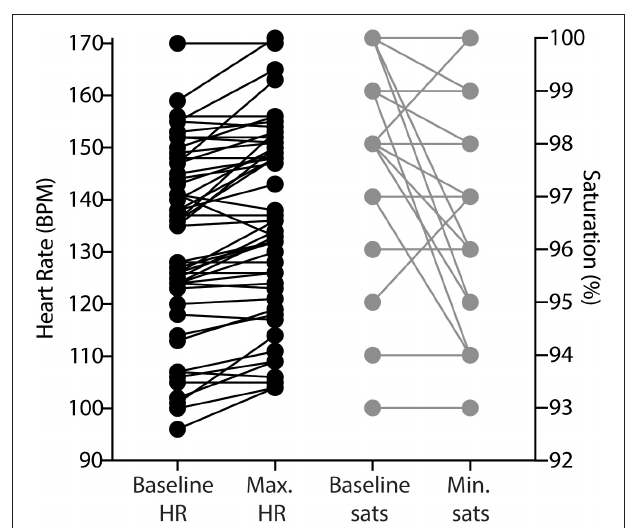
FIGURE 4 | Change in heart rate and oxygen saturation during accelerometry measurements. Dots indicate individual trial read-outs; lines indicate within-trial measurement. BPM, beats per minute; HR, heart rate; sats., oxygen